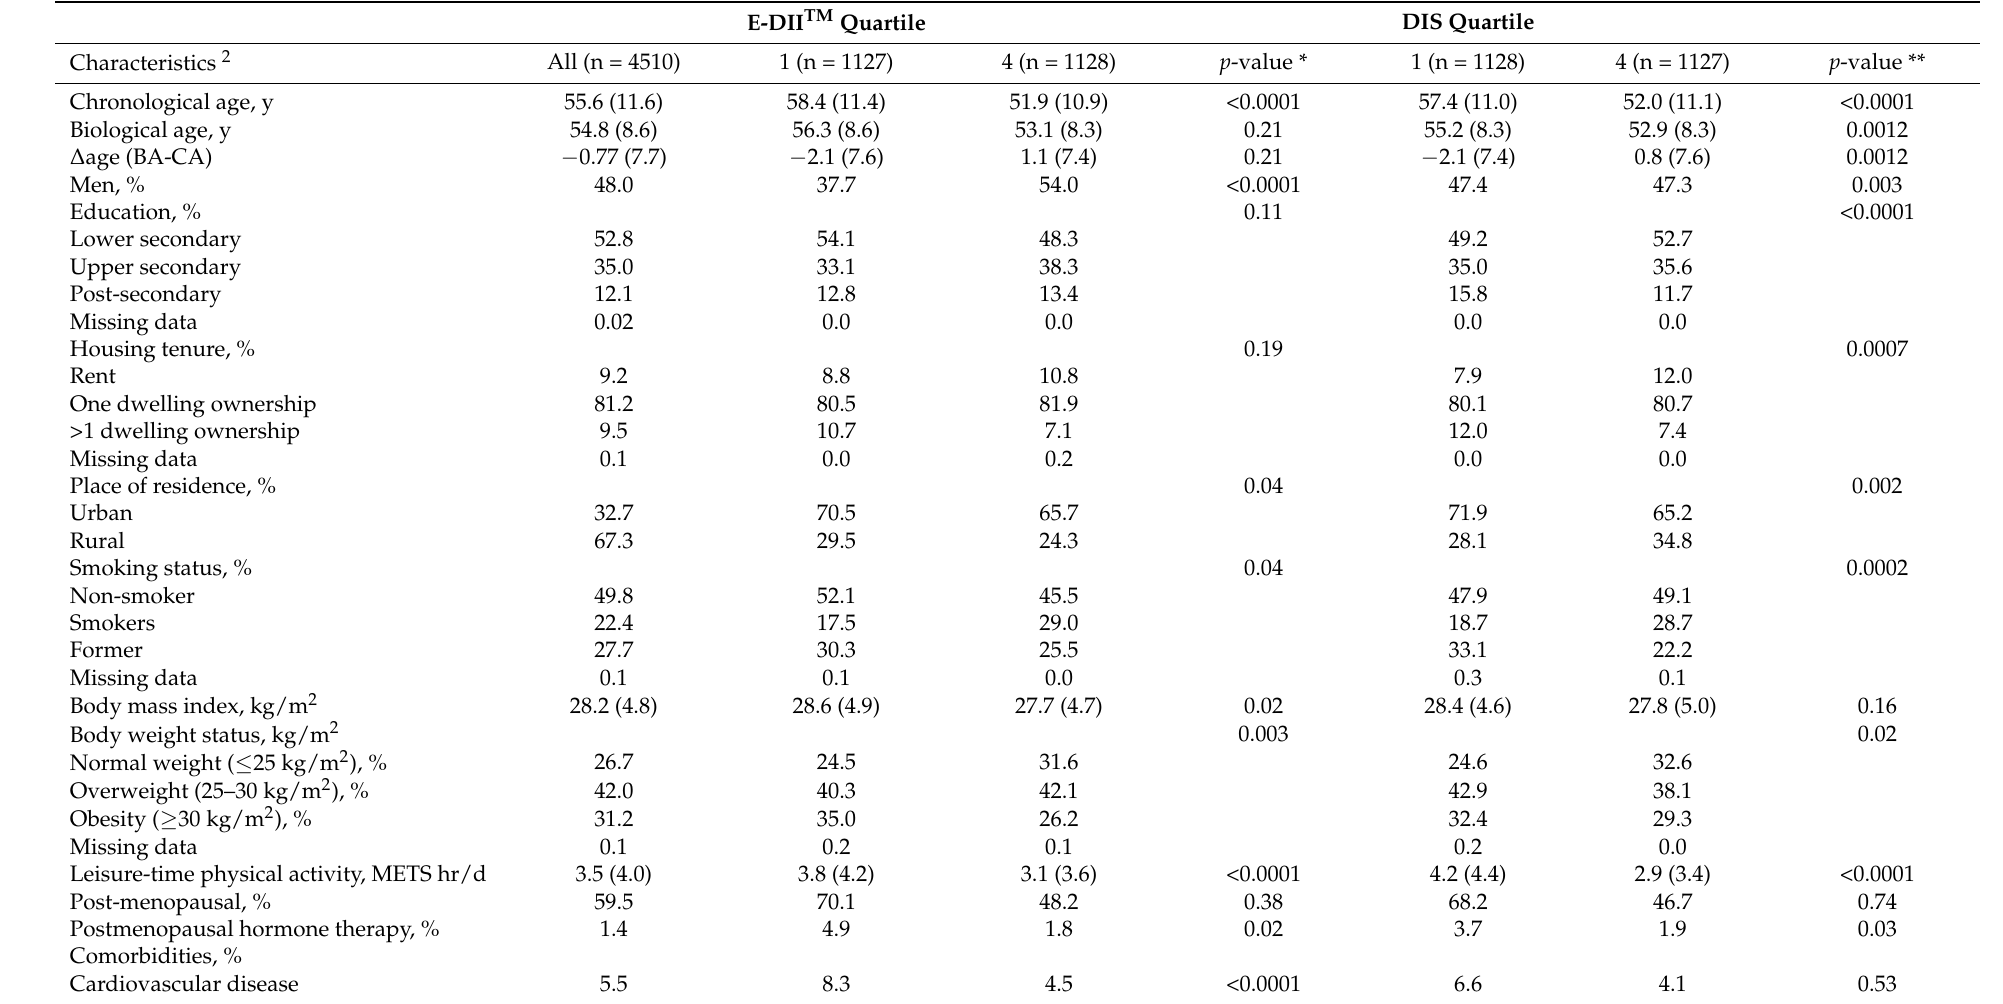
Table 1. Selected characteristics of the participants in Moli-sani sub-cohort (n = 4510) across quarters of the Energy-adjusted Dietary Inflammatory Index (E-DII) and the Dietary Inflammation Score (DIS) 1